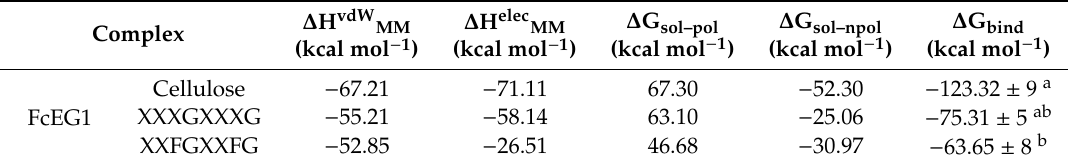
Table 2. MM-GBSA analysis for the interaction of the di ff erent complexes formed between FaEG1 with the di ff erent XG and cellulose ligands.